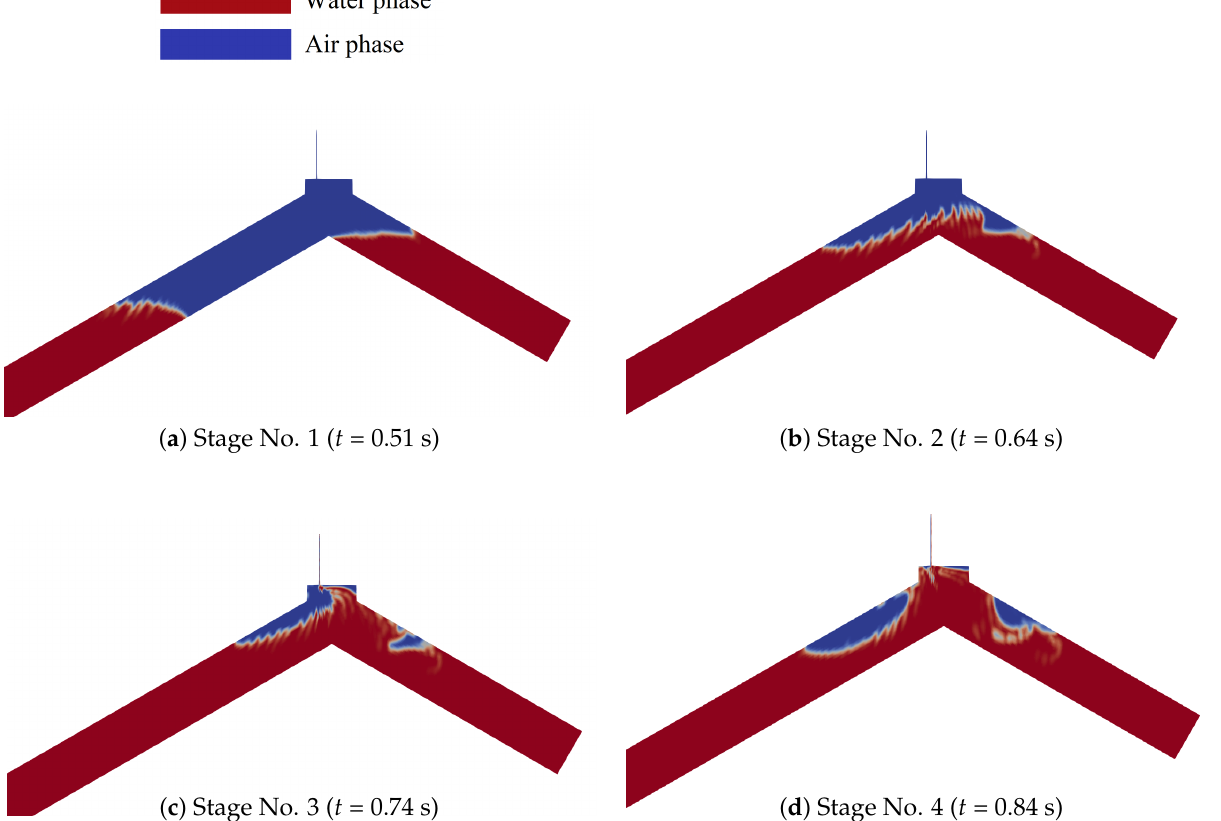
Figure 6. Air–water interface during stage 1 to 4 ocurrences for experimental test 1.